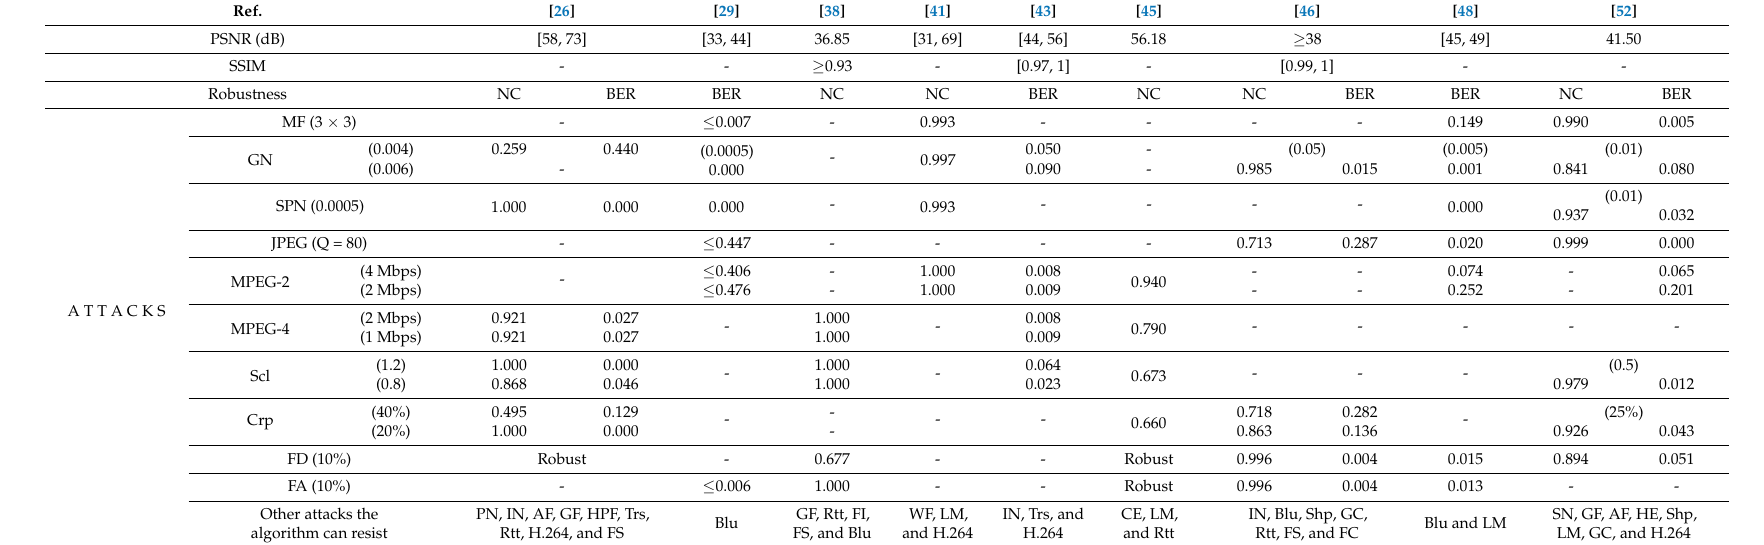
Table 7. Quantitative comparison of invisibility and robustness of several typical algorithms in spatial, DCT, and DWT domains. Ref.